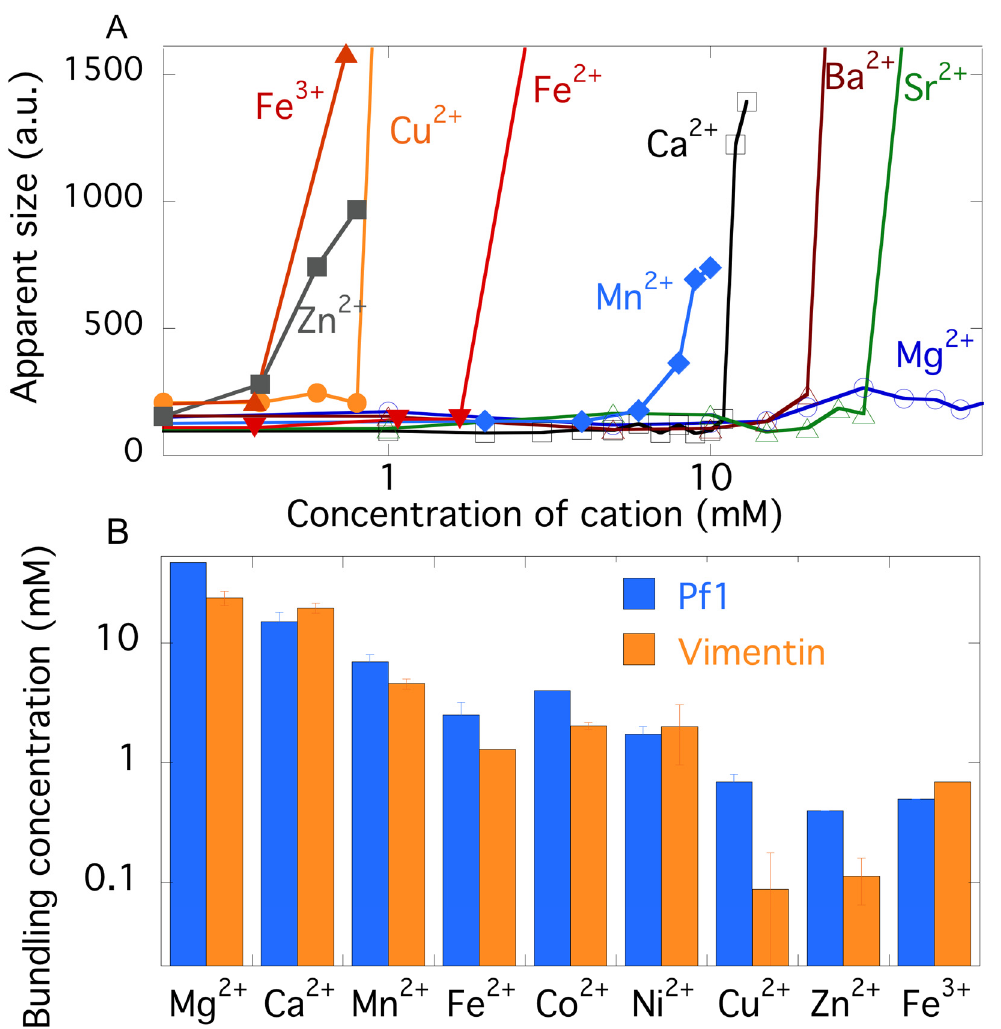
Figure 3. Counterion dependent attraction of like charged polyelectrolytes by various divalent and higher valence cations. ( A ). Changes in apparent size calculated from the diffusion constant as measured by decay of light scattering autocorrelation function for initial suspensions of single virus as they are titrated with increasing concentrations of biologically relevant alkaline earth and transition metal ions. ( B ). Comparison of the efficiency of different metal counterions to aggregate Pf1 and vimentin intermediate filaments (VIFs). Error bars denote standard errors for experiments in which 3 separate preparations of Pf1 or VIFs were titrated by the counterions. In all cases the correlation functions were averages of at least five different measurements of the same